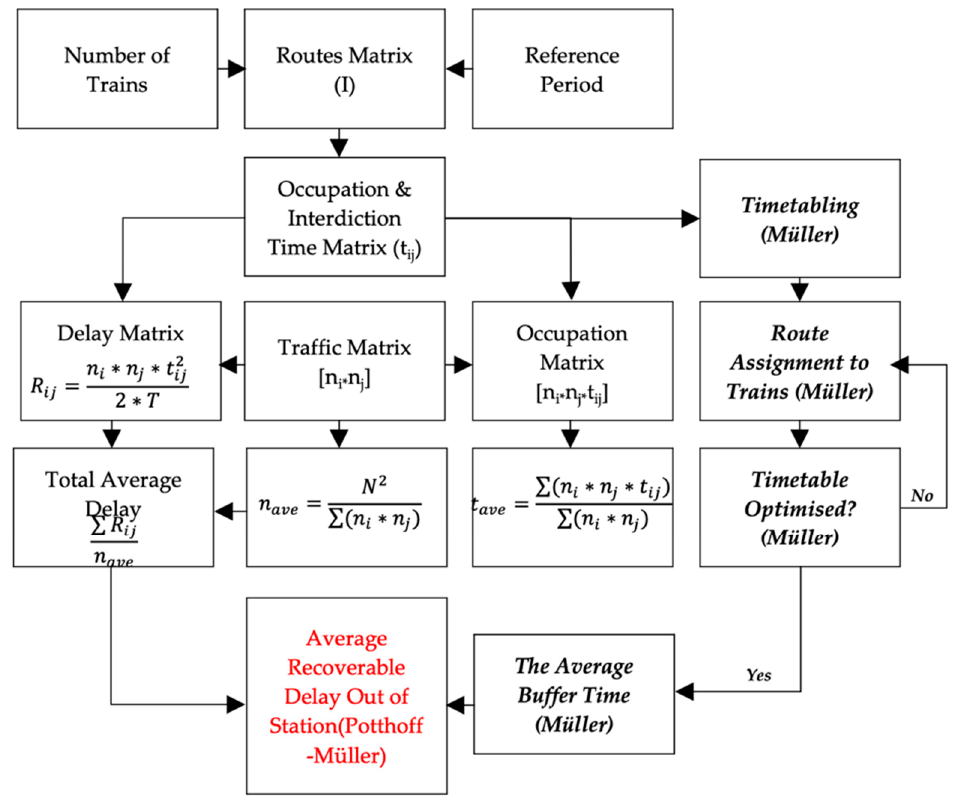
Figure 3. Potthoff and Müller methods integrated procedure.